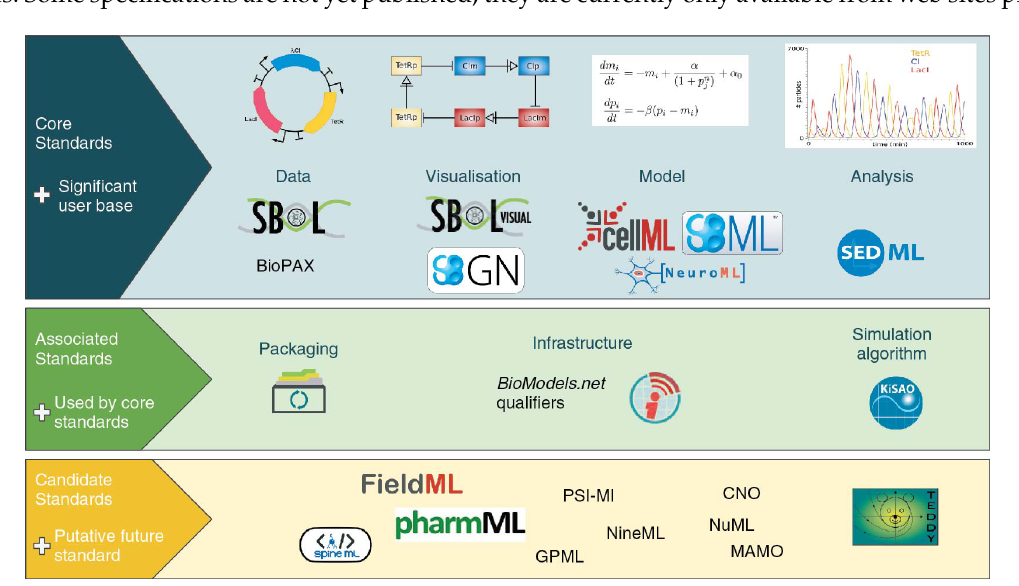
Figure 1: Overview of standards and associated standardisation efforts in Systems and Synthetic Biology covered by COMBINE (from